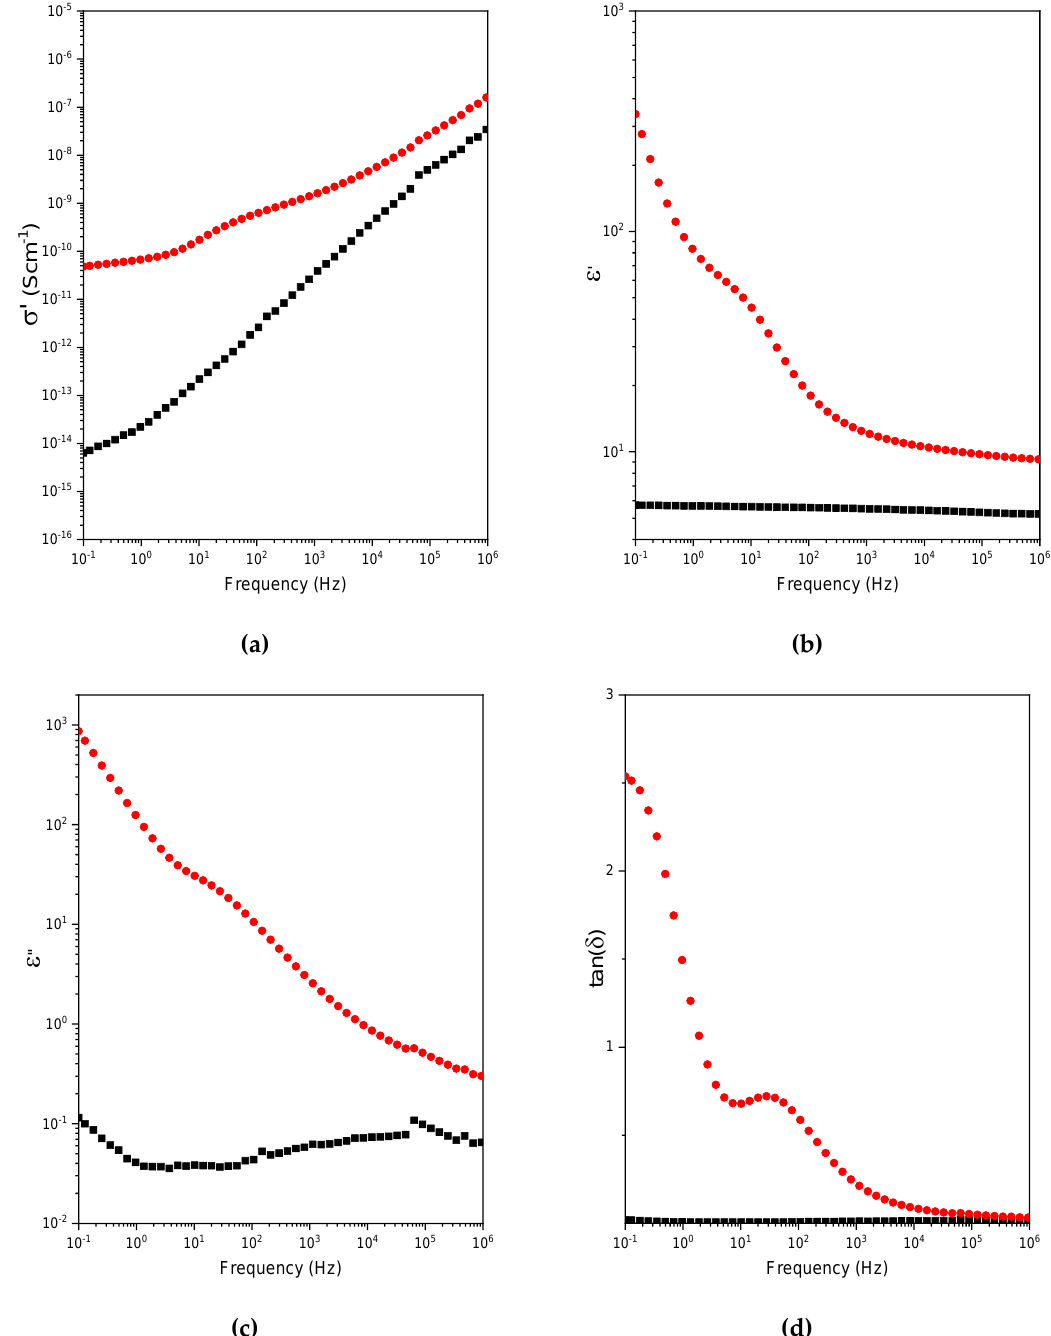
Figure 3. ( a ) Electrical conductivity ( σ’ ), ( b ) dielectric permittivity ( ε’ ), ( c ) dielectric loss ( ε’’ ) and ( d ) loss